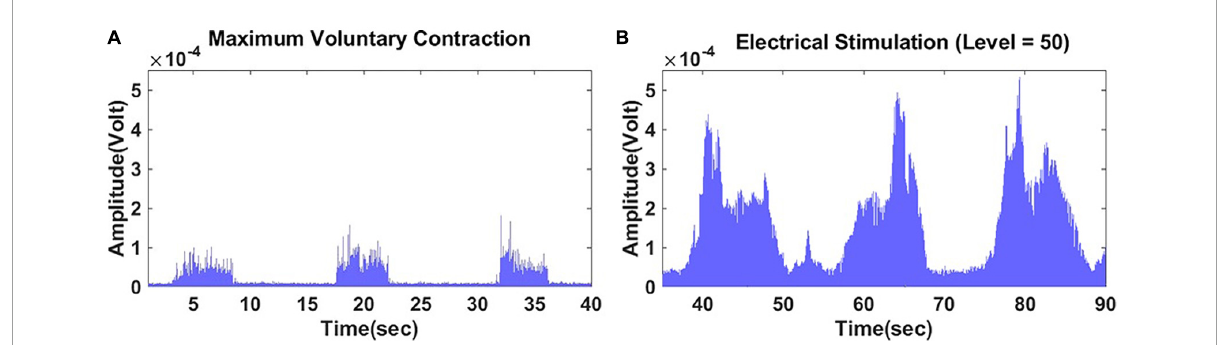
FIGURE2 A typical case comparison between a maximum voluntary contraction and involuntary contraction of the gastrocnemius muscle assessed via surface electromyogram. (A) Three 5–10 s dorsiflexion maximum voluntary contractions. (B) Three 5–10 s intervals of electrical stimulation set at 50 V. Both panels having a 5–10 s relaxation period between